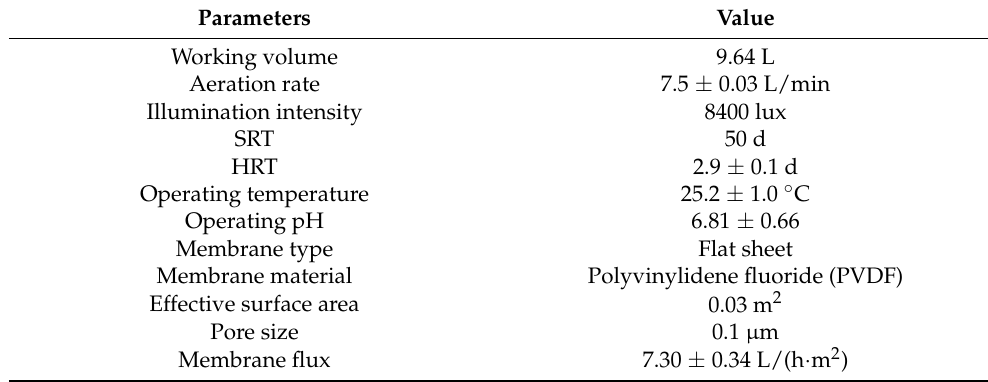
Figure 1. Experimental setup of the MPBR. Table 1. Operating conditions and membrane module properties of the MPBR system.